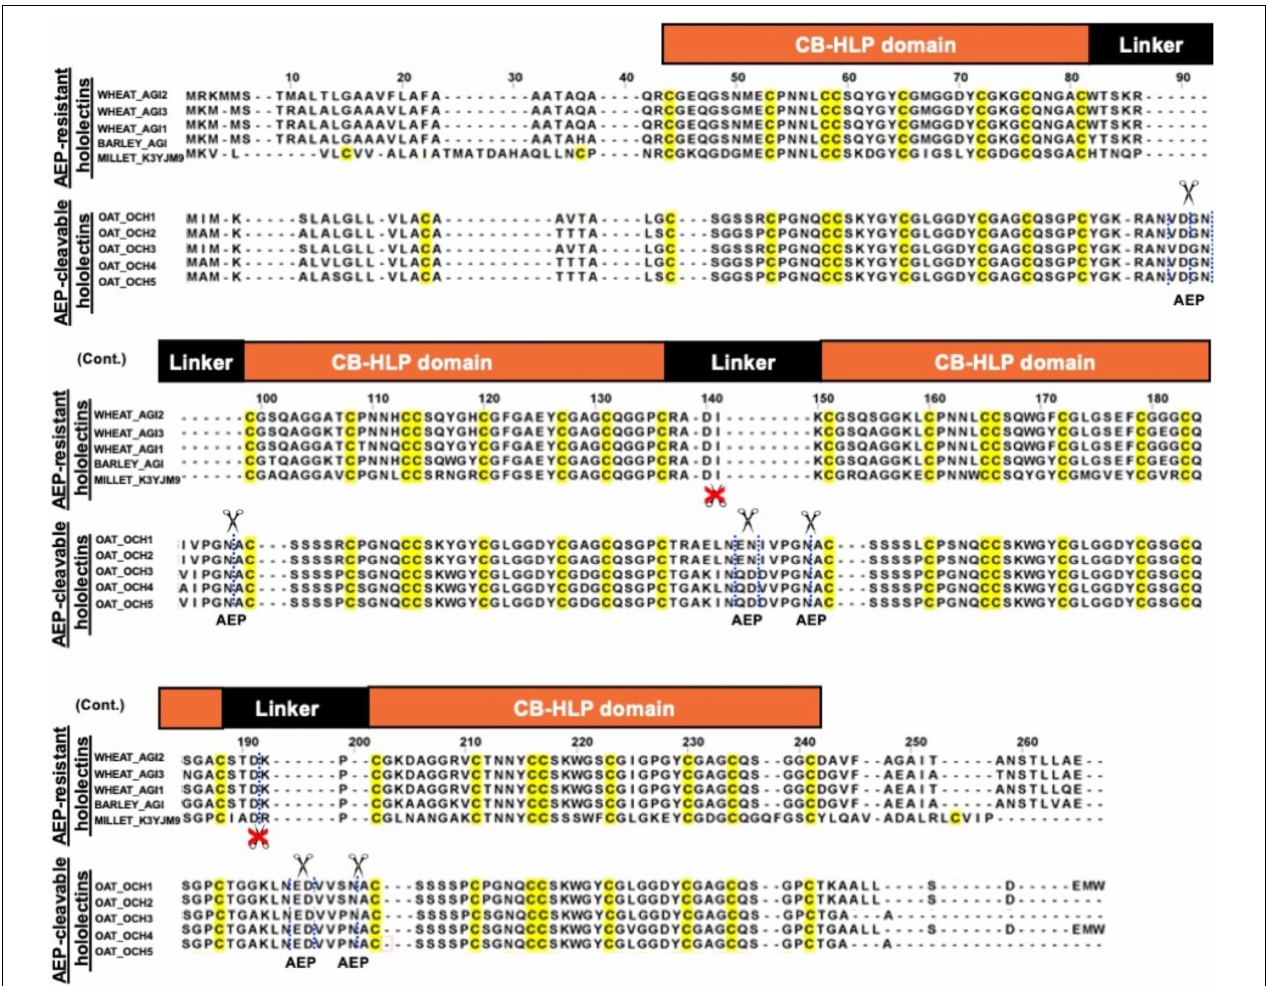
FIGURE 8 | Sequence alignment of AEP-resistant hololectin (e.g., WHEAT_AGI1, P10968; WHEAT_AGI2, P02876; WHEAT_AGI3, XP_037472823.1; BARLEY_AGI, P15312; MILLET_K3YJM9, XP_004972860.1) and putatively AEP-cleavable hololectin OAT_OCH1-5 (e.g., GO581539.1, GO581912.1, GO582252.1, GO583188.1, GO585827.1) precursor sequences from common